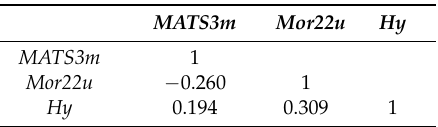
Figure 1. Observed versus predicted log % DPPH for the coumarinyl Schiff bases calculated by model (1). Table 3. Correlation matrix for the descriptors included in model 1.